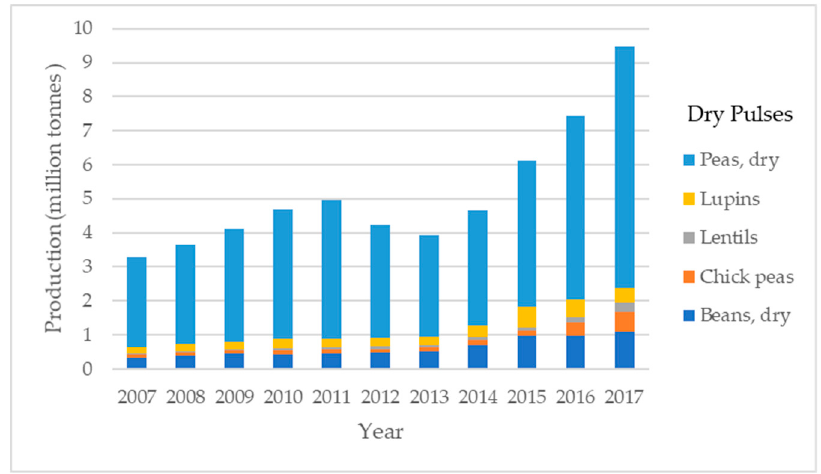
Figure 1. Evolution of harvest production (million tons) of dry pulses by species on Europe.